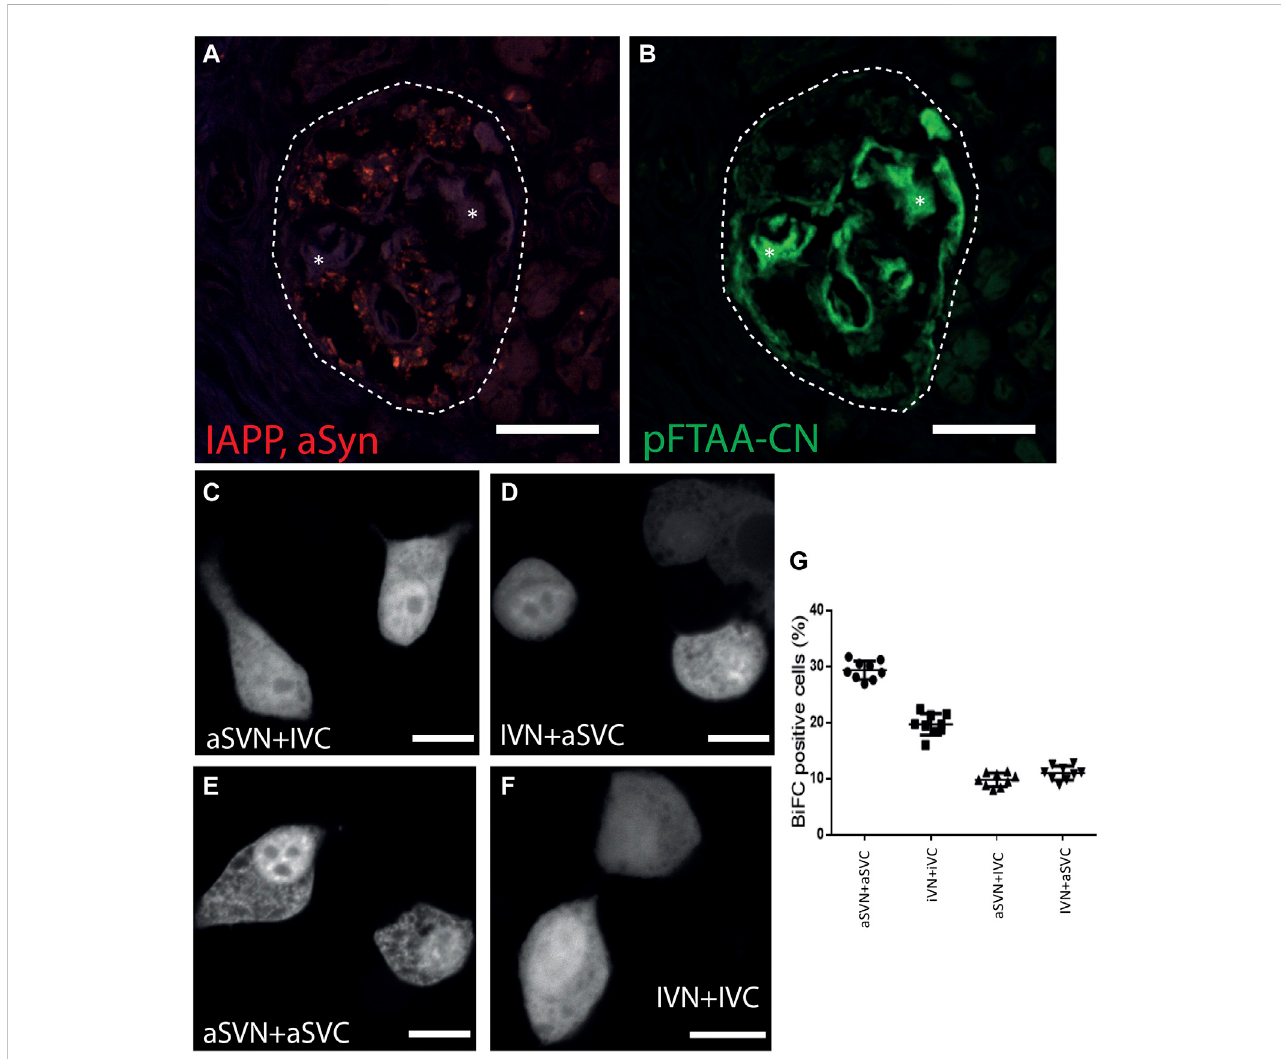
FIGURE 2 ASyn co-localize with IAPP intracellular but not with islet amyloid. PLA was performed on formalin- fi xed paraf fi n-embedded human pancreas sections using aSyn and IAPP antibodies. (A) Positive PLA signals (red dots) were detected in human islets, indicating that aSyn and IAPP were located within 40 nm. After PLA, the same sections were incubated with (B) pFTAA-CN to visualize islet amyloid, which demonstrated that PLA signals were not present in the islet amyloid area. BiFC constructs were expressed in HEK 293 cells to study aSyn (61 – 95) and IAPP interaction. Confocal images of BiFC-positive cells expressingaSVN+IVCin (C) ,andIVN+aSVCin (D) ,aSVN+aSVCin (E) andIVN+IVCin (F) .In (G) ,percentagesofBiFC-positiveHEK293cellsweredetermined by fl ow cytometry. Asterisks denote corresponding areas in both pictures. Scale bars are 50 µm in (A, B) , 10 µm in (C – F)